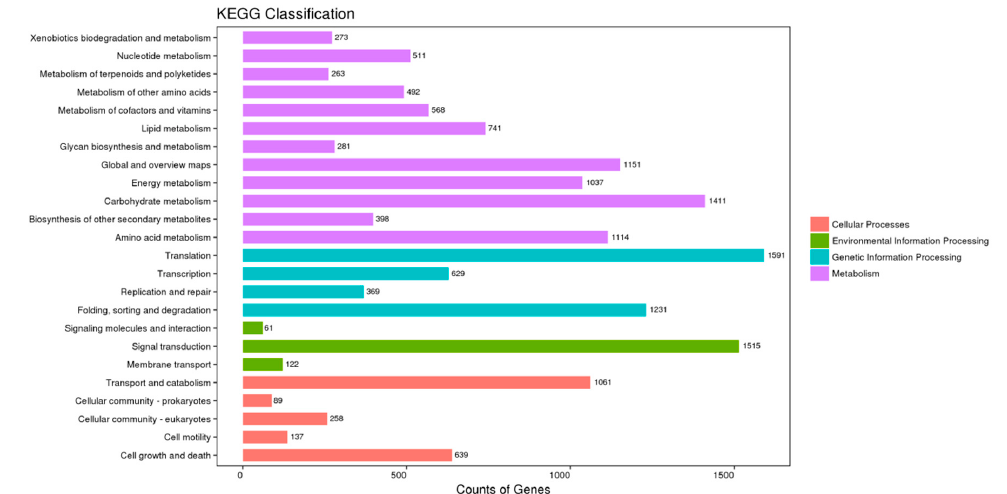
Figure 3. Functional distribution of Kyoto Encyclopedia of Genes and Genomes (KEGG) annotation. The x -axis represents the number of genes, and the y -axis represents the name of the KEGG metabolic pathway.